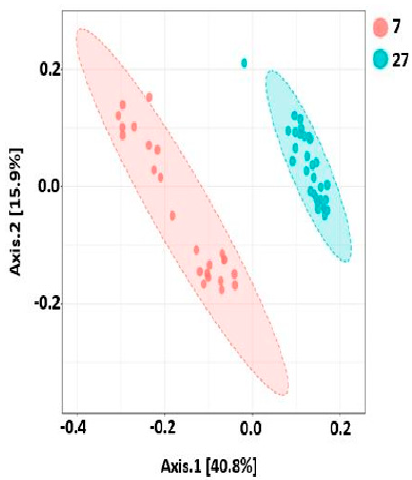
Figure 11. PCoA plot showing significant difference in bacterial community structure among piglets of two post weaning ages (ANOSIM; R = 0.76 and p < 0.001). Unweighted UniFrac distance metric was used to create PCoA plot. 7 and 27 represent 7 and 27 days respectively after weaning.